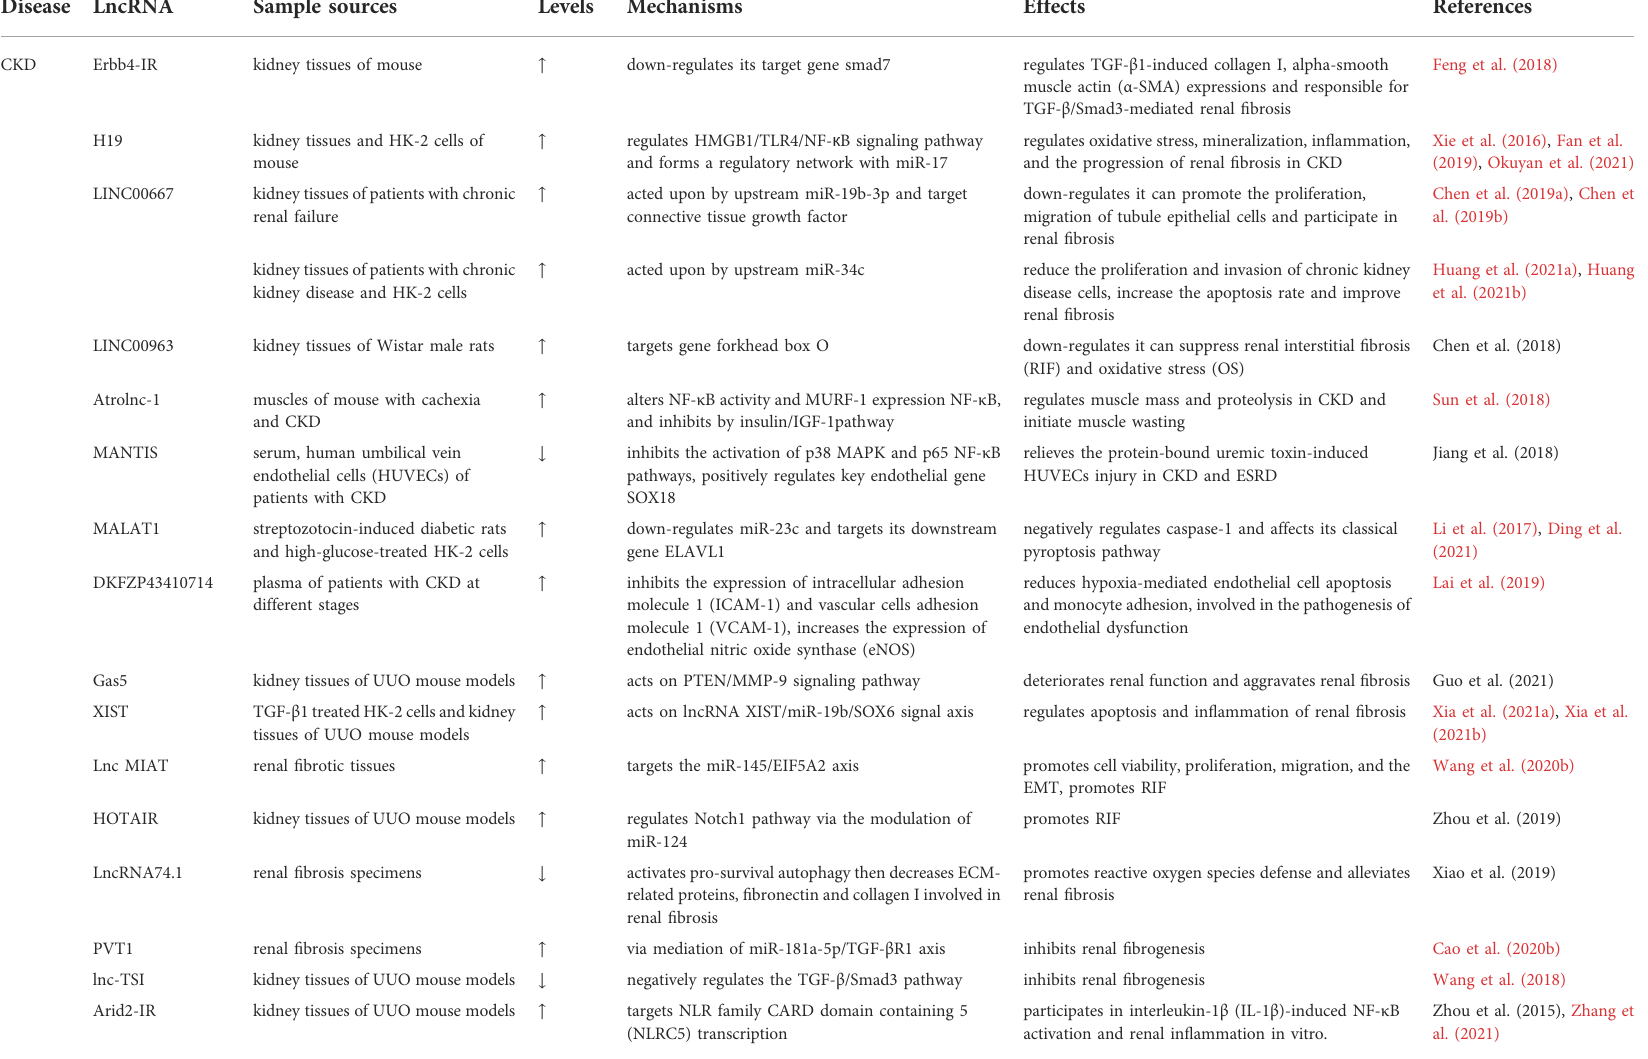
TABLE 1 Levels, effects and functions of lncRNAs in experiments in kidney